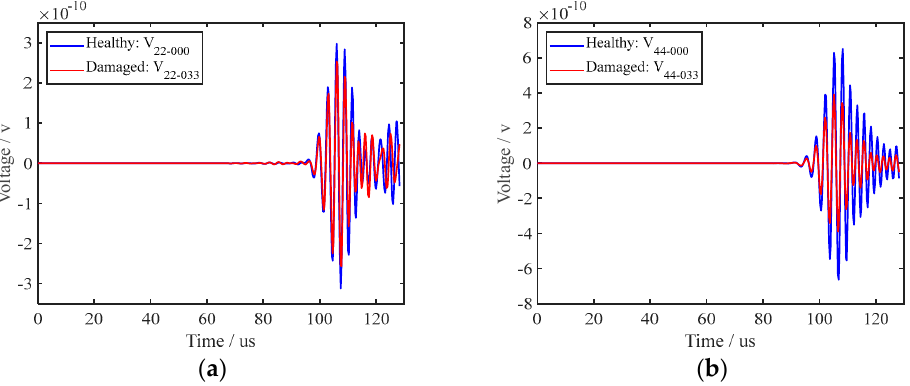
Figure 10. Signal comparison of UGW with and without transverse cracks in the rail bottom; ( a , b ) are paths E2-R2 and E4-R4, respectively.